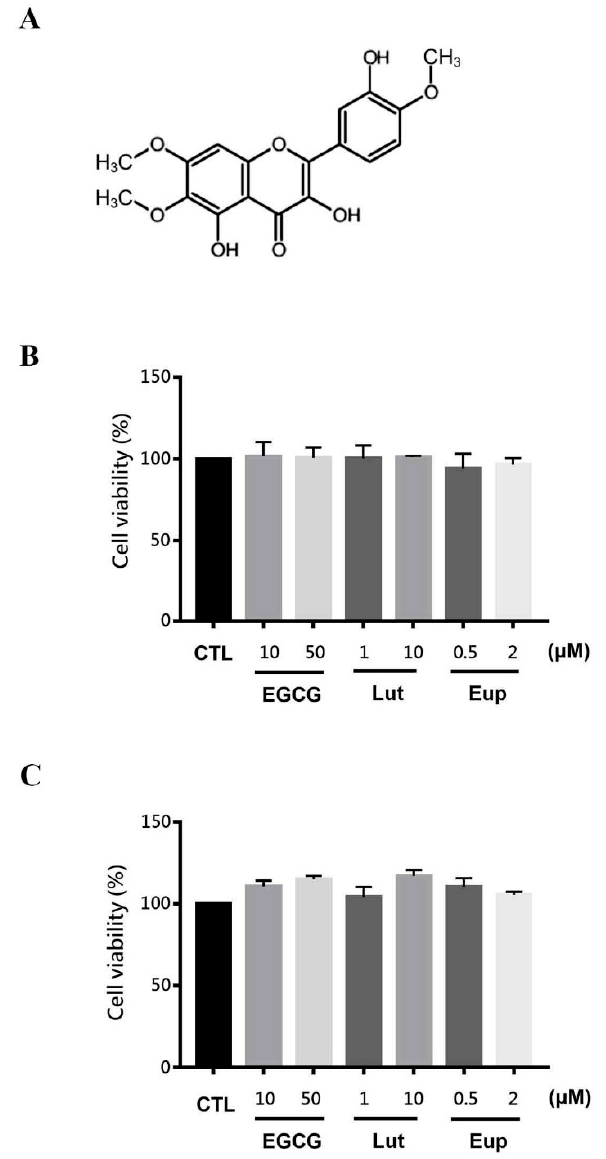
Figure 1. Eupatin cell viability. ( A ) Eupatin chemical structure. ( B , C ) 24-h incubation of ( B ) RAW264.7 and ( C ) Neuro-2a cells with or without the specified eupatin, luteolin, and EGCG concentrations. MTT assay was employed for determining cell viability. The results are presented as the mean ± standard error of the mean of three independent experiments.